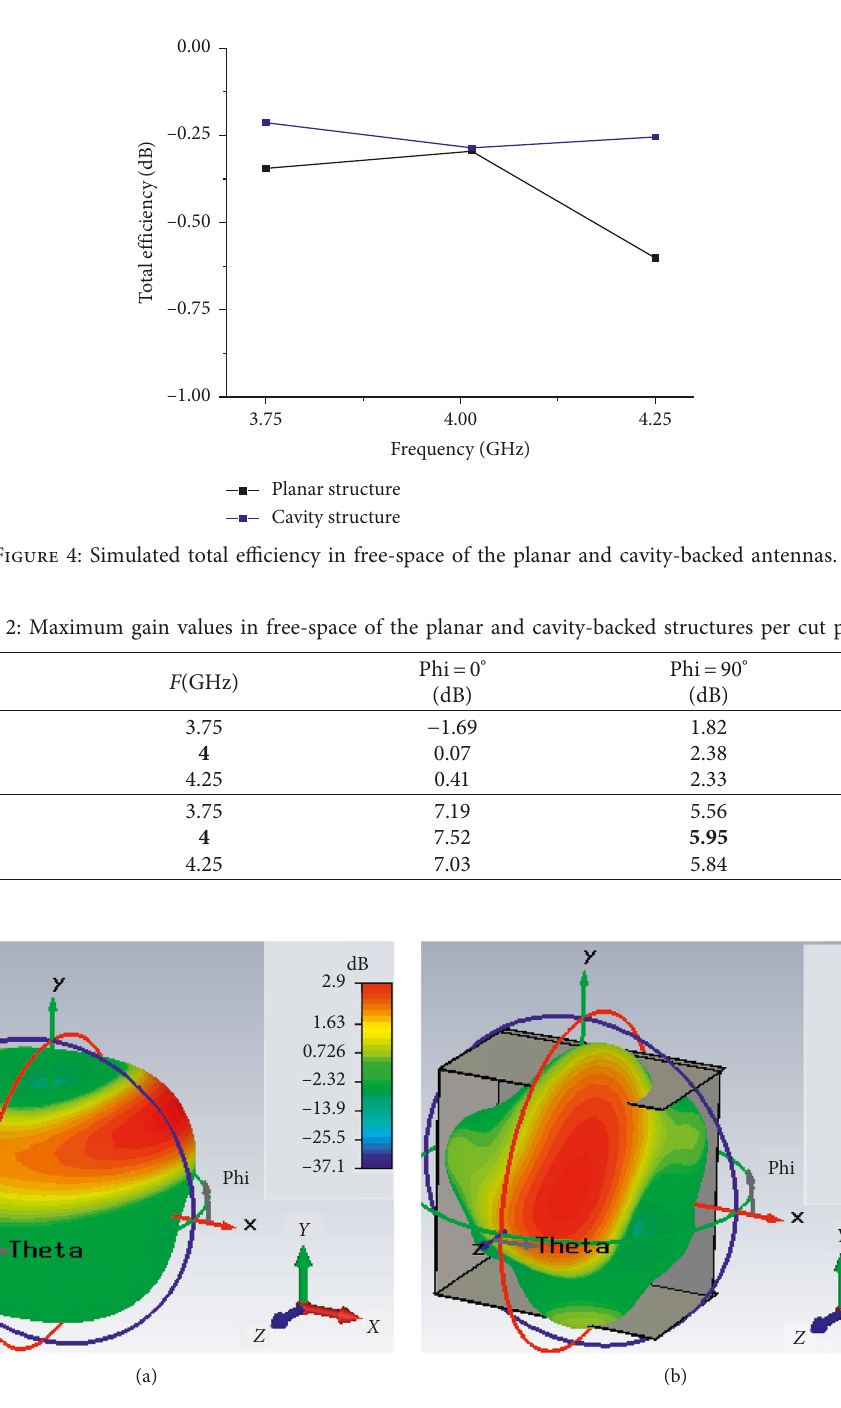
Figure 5: Simulated 3D radiation pattern in free-space at 4 GHz of the (a) planar and (b) cavity-backed